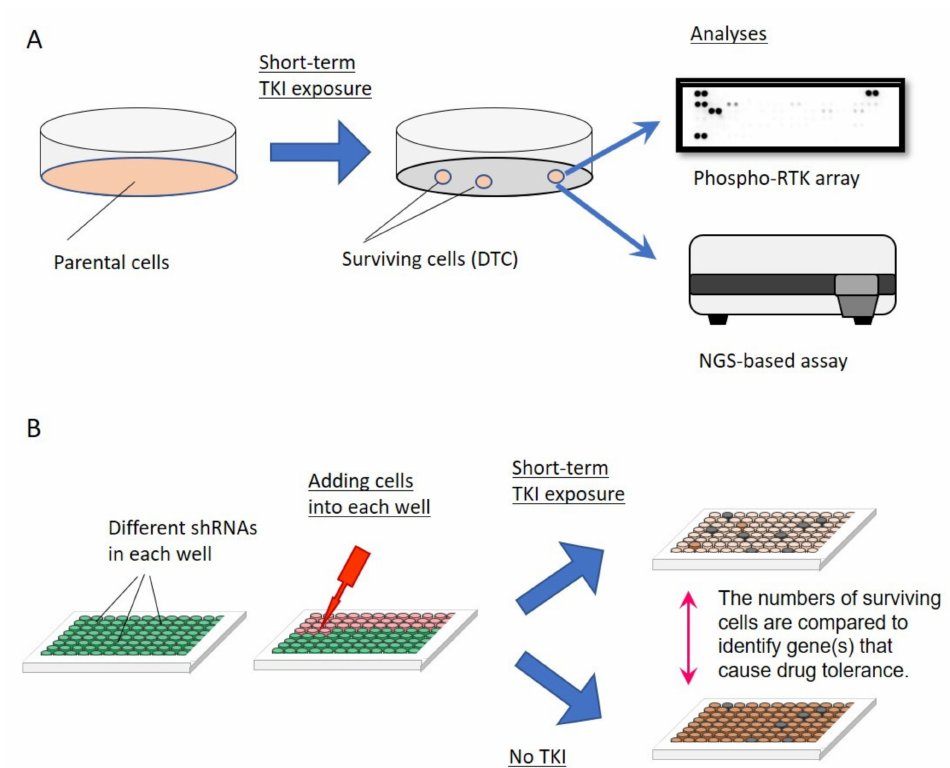
Figure 2. Strategies to explore the molecular mechanisms of drug-tolerant cells (DTCs). ( A ) EGFR - mutated lung cancer cell lines are subjected to short-term treatment with an EGFR TKI at clini- cally equivalent concentration(s). The remaining cells are collected and comprehensive analyses are performed to identify activated molecules/signaling pathways in the presence of EGFR